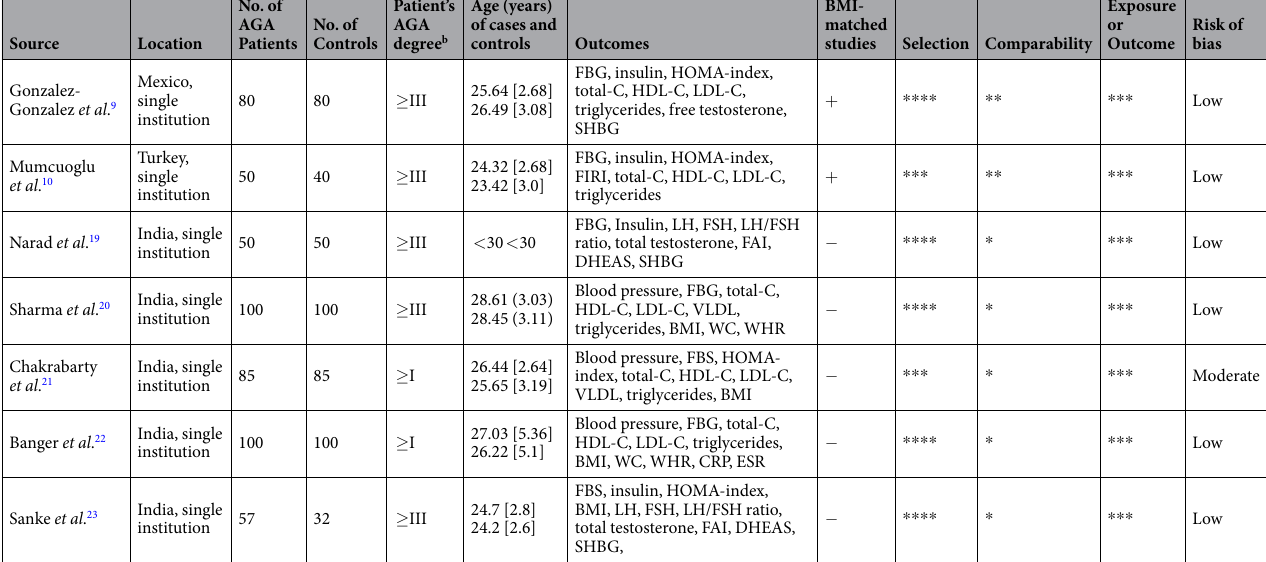
Table 1. Summary of the studies included and their quality assessment a . Abbreviations: AGA = androgenetic alopecia; BMI = body mass index; CRP = C-reactive protein; DHEAS = dehydroepiandrosterone sulphate; ESR = erythrocyte sedimentation rate; FAI = free androgen index; FBS = fasting blood sugar; FIRI = fasting insulin resistance index; HDL-C = HDL cholesterol; LDL-C = LDL cholesterol; SHBG = sex hormone binding globulin; total-C = total cholesterol; VLDL = very low-density lipoproteins; WC = waist circumference; WHR = waist to hip ratio. Values in square brackets represents the standard deviation, whereas those in round brackets represents the mean difference. a The quality assessment of individual studies was based on the Ottawa– Newcastle scale 52 . Possible scores are 0 to 4 asterisks for selection, 0 to 2 for comparability, 0 to 3 for exposure or outcome. One asterisk indicates the lowest score, 4 asterisks the highest score. Studies with a score < 5 were considered to have high risk of bias, between 5 and 7 moderate risk, > 7 low risk of bias. b The degree of androgenetic alopecia was evaluated though the Hamilton-Norwood Scale 50, 51